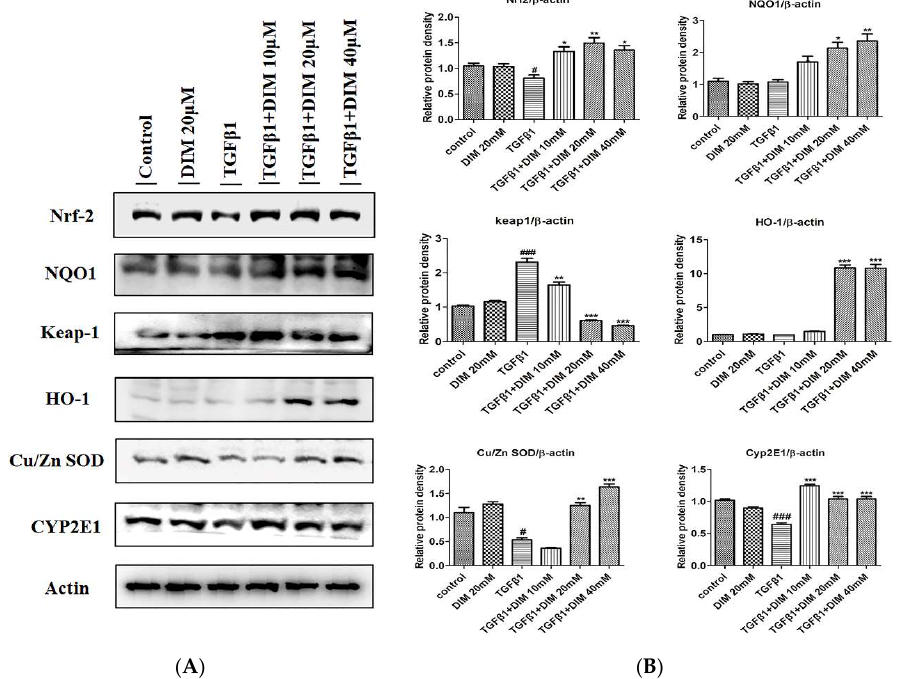
Figure 6. DIM treatment enhances antioxidant ability by activating Nrf2/HO-1 signaling pathway and reducing oxidative stress in TGF-β1-induced hepatocytes injury. ( A ) Protein expression levels of Nrf2, NQO1, Keap-1, HO-1, Cu/Zn SOD, and hepatic cytochrome P450 (CYP2E1) at 24 h after TGF-β1 treatment were determined by Western blot analysis. ( B ) Quantification of proteins expres- sion normalized to β-actin. Data are expressed as mean ± SE of three individual experiments ( n = 3). # p < 0.05, and ### p < 0.001 denotes significant differences compared to the control; * p < 0.05, ** p < 0.01 and *** p < 0.001 compared to treatment with TGF-β1 only.